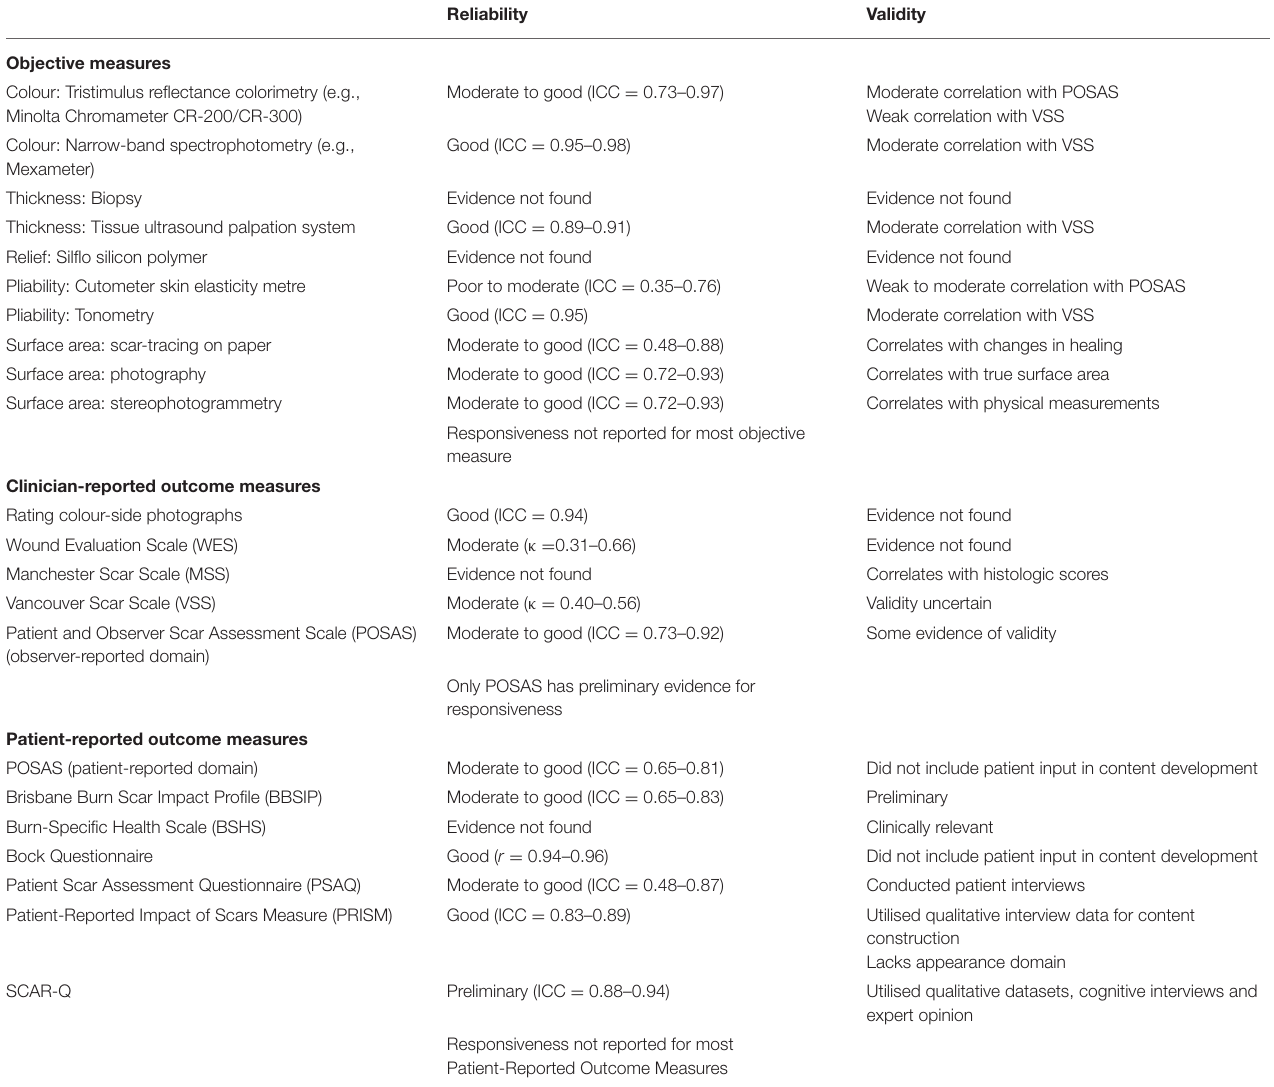
TABLE 1A | Reliability, validity, and responsiveness of existing assessment tools, as reported in the literature